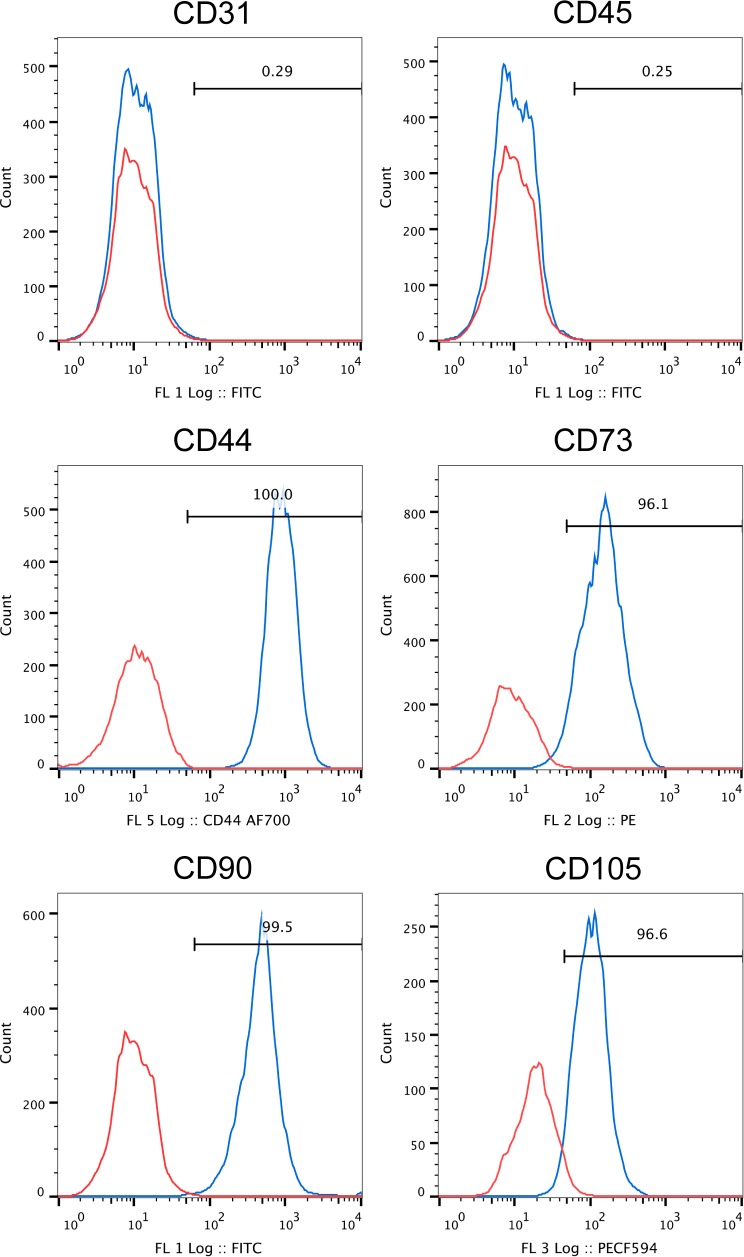
Flow cytometry analysis of FACS derived human PSC.Human PSC, as defined by FACS purification from human lipoaspirate, were examined at passage eight by flow cytometry. Expression is shown in blue in relation to unstained control in red. No expression of CD31+ endothelial or CD45+ inflammatory cells among FACS purified human PSC. Near universal expression of canonical ‘MSC’ markers among FACS purified human PSC, including CD44, CD73, CD90, and CD105 (frequency: 96.1–100%).